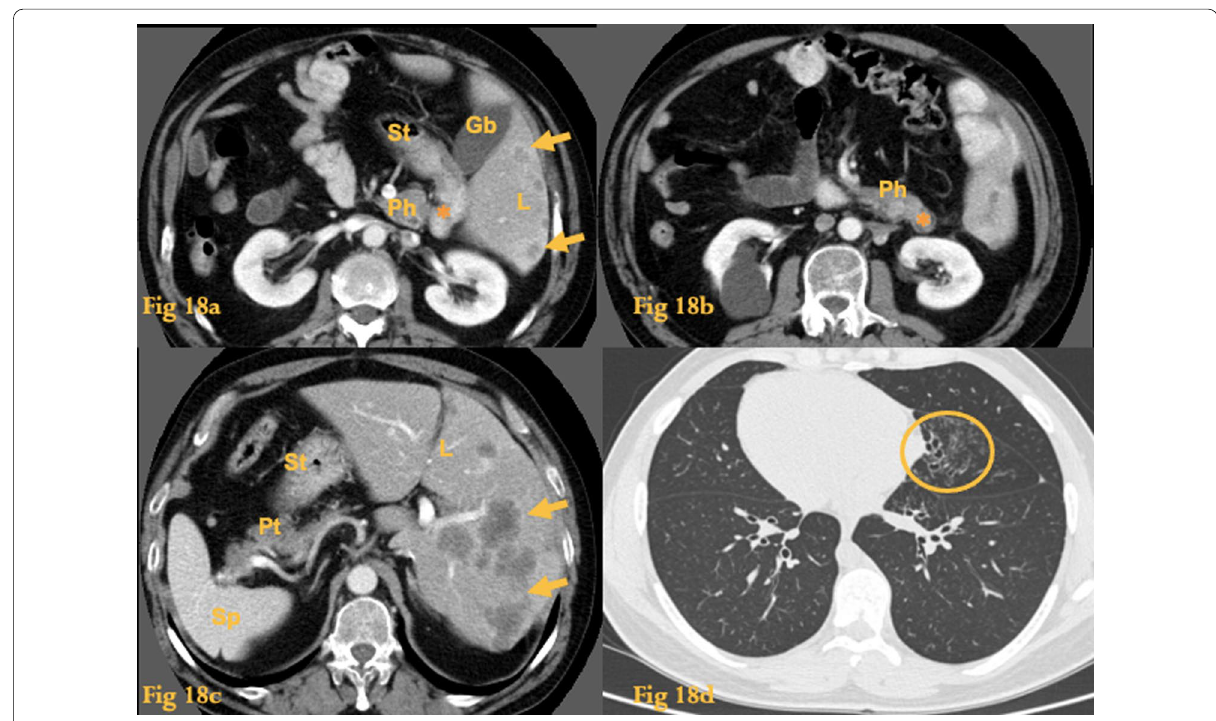
Fig. 18 Kartagener syndrome. Abdominal CT of a patient with situs inversus. There are hypodense liver lesions (arrows) corresponding to metastases from colon cancer ( a , c ). The duodenum accompanies the mirror image of the other abdominal organs. Asterisk descending = duodenum. L liver; S spleen; St stomach; Ph head of the pancreas; Pt tail of the pancreas; Gb gallbladder. Thoracic CT of another patient = = = = = = ( d ) with situs inversus and Kartagener syndrome shows bronchiectasis in the middle lobe of the left lung